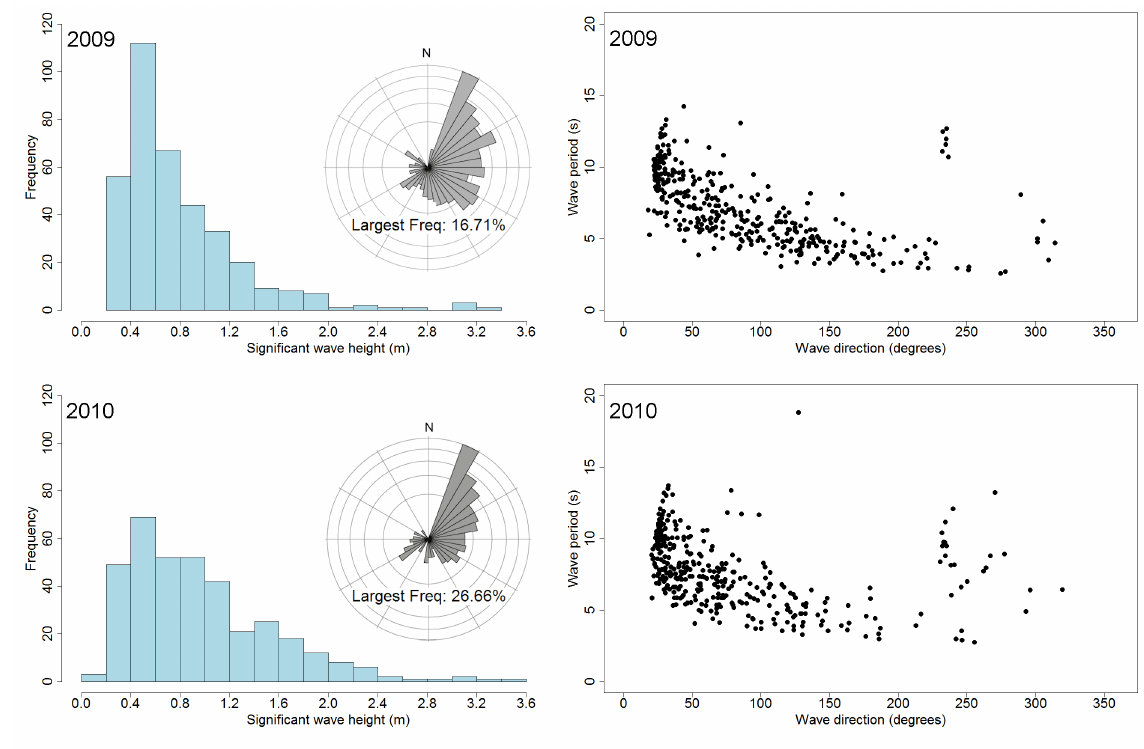
Figure 2. Wave climates used in the modelling. The data are daily averages, calculated from the data recorded every 30min by the Hornsea WaveRider III buoy (CCO, 2013). The rose diagrams show the direction from which the wave is travelling. The “petals” are in 10 ◦ intervals and area-scaled by frequency percentage. The dominance of waves travelling from northeasterly directions is clear, particularly during 2010. Note the low frequencies of waves travelling in offshore directions. The histograms show that significant wave height data are positively skewed, but with marked variations in height frequencies over each year. Neither are well fitted to standard distributions, either in raw or transformed form. Overall, there were greater frequencies of higher waves in 2010, suggesting more unsettled weather than in 2009. N = 365 in both roses and